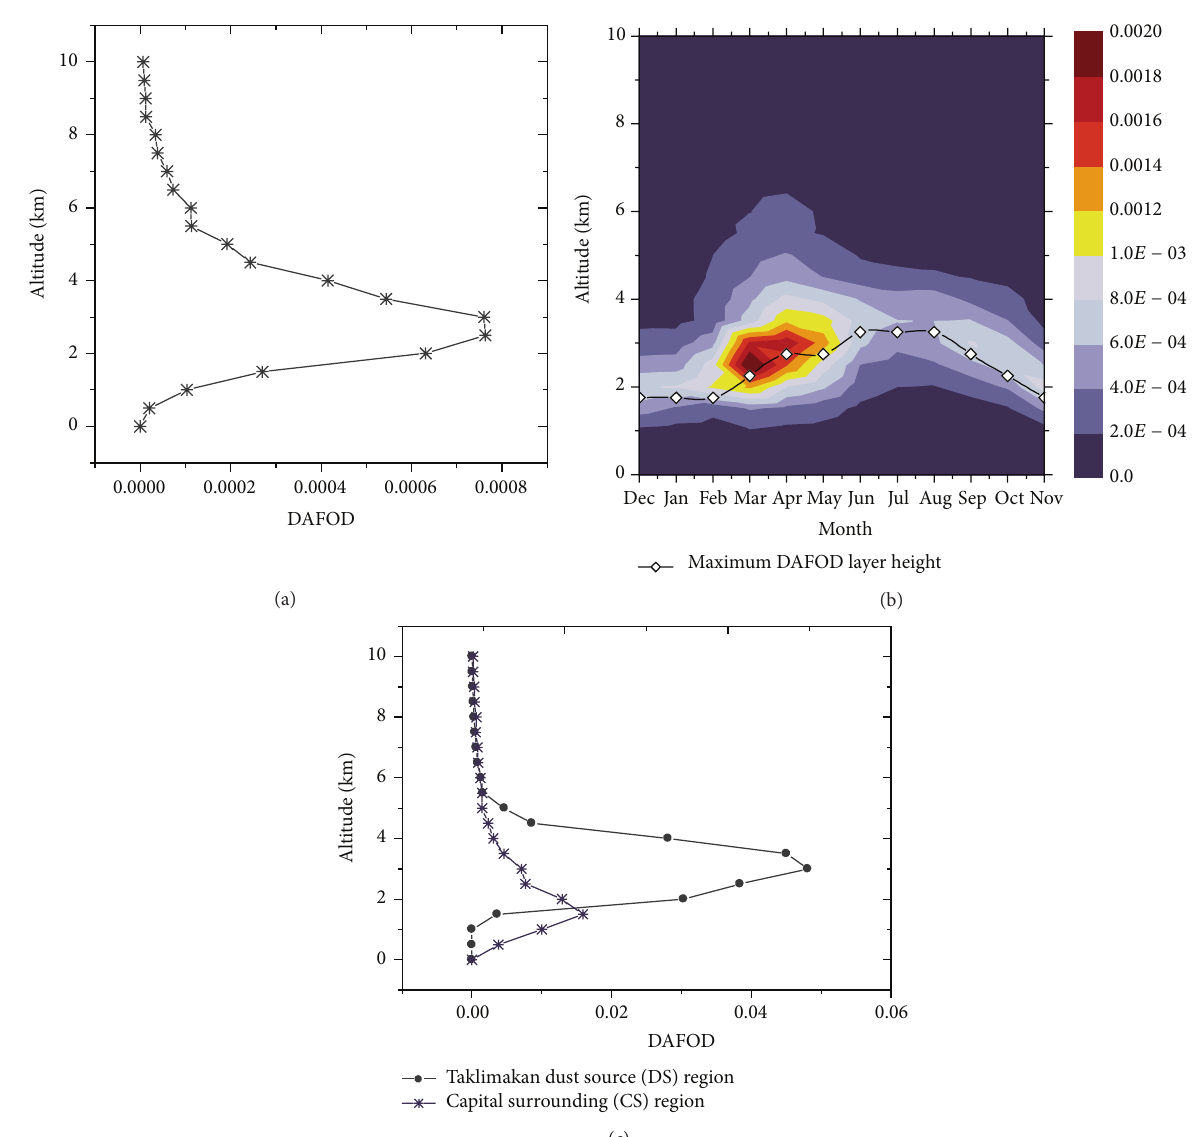
Figure 5: The (a) multiyear averaged DAFOD profile along with its (b) intra-annual variation pattern over China as measured by CALIOP from 2007 to 2014. The black quadrangle line shows the monthly mean vertical maximum DAFOD layer altitude. (c) The comparison of the multiyear averaged DAFOD profile between Taklimakan dust source and capital surrounding (far away from the source region) areas of